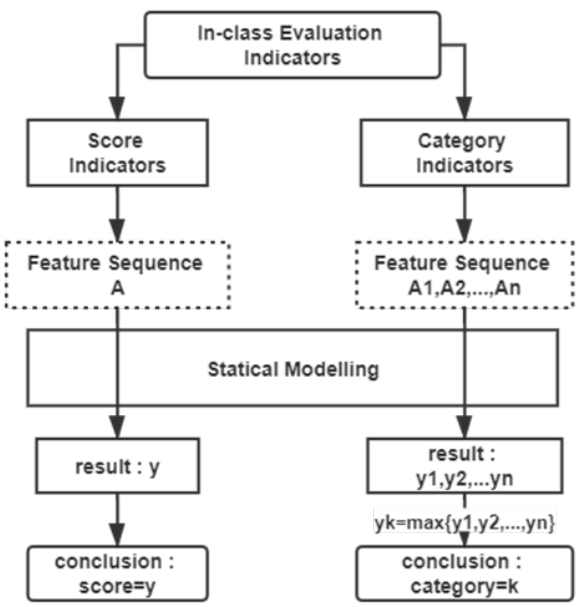
Figure 5. In-class teaching statistical modeling.